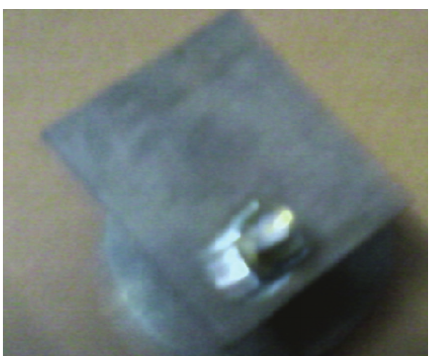
Figure 13: Ground plane of proposed antenna.